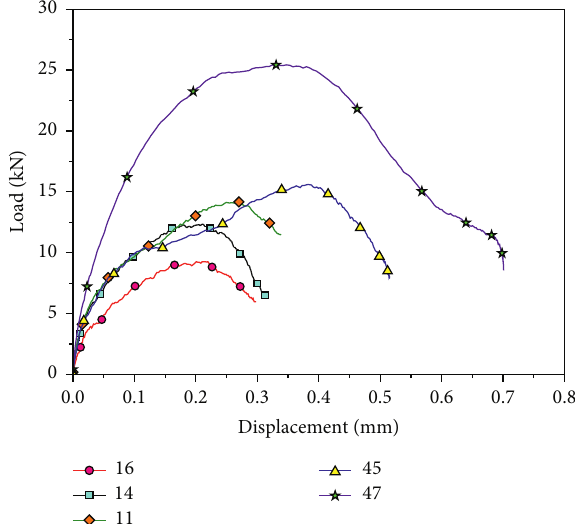
Figure 4: Typical dynamic load-displacement curves.